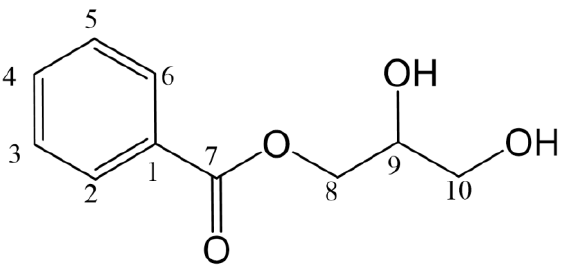
Figure 12. Structure of